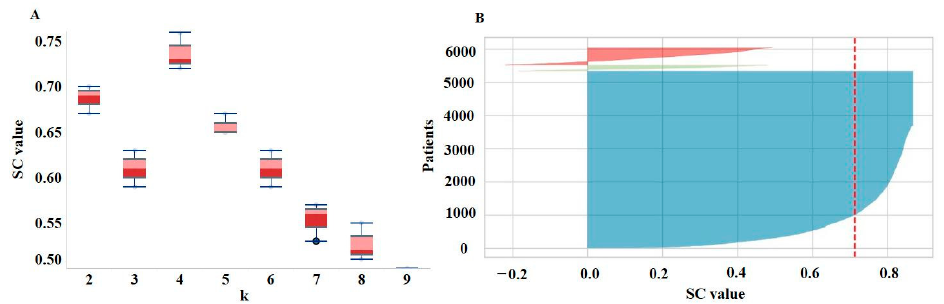
Figure 5. SC analysis.